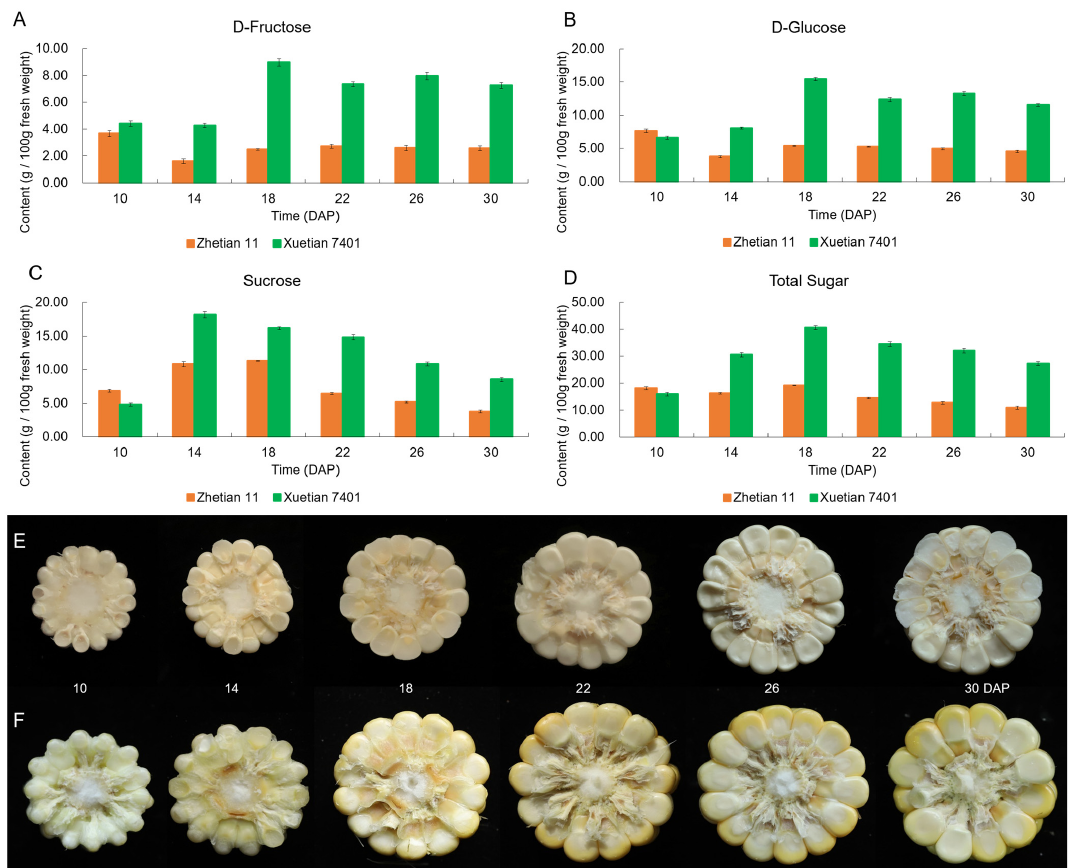
Figure 1. Dynamic changes in the three sugar contents in developing kernels of Xuetian 7401 and Zhetian 11. ( A – C ) Dynamic changes in D ‐ fructose ( A ); D ‐ glucose ( B ); sucrose ( C ); and total sugar ( D ) in developing kernels of Xuetian 7401 and Zhetian 11. ( E , F ) Cross ‐ sections of the developing ears of Xuetian 7401 ( E ) and Zhetian 11 ( F ). Data in ( A – C ) are mean ± SE. ( D ) in developing kernels of Xuetian 7401 and Zhetian 11. ( E , F ) Cross-sections of the developing